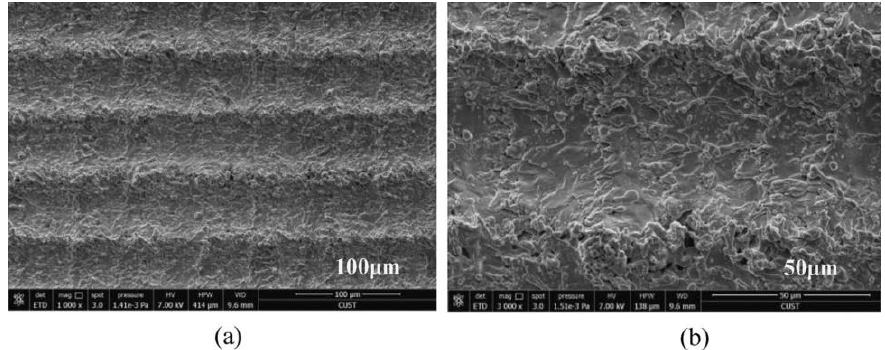
Figure 17. SEM image of laser-induced superhydrophobic surface when the scanning spacing is greater than the beam diameter ( a ) 100 µ m length scale ( b ) 50 µ m length scale (Reprinted with permission from Ref. [47]. 2021, Zhang, L.).